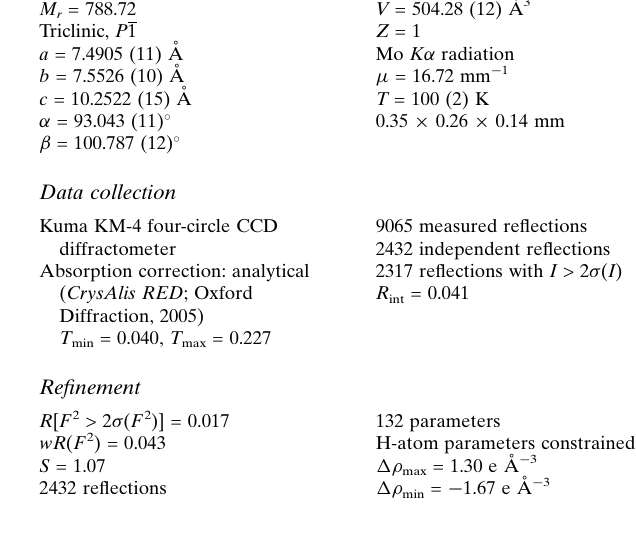
Kuma KM-4 four-circle CCD diffractometer Absorption correction: analytical ( CrysAlis RED ; Oxford